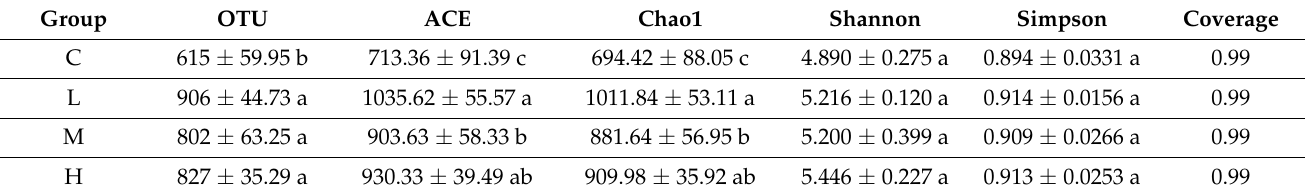
Table 1. Sequence information and diversity index of microbial